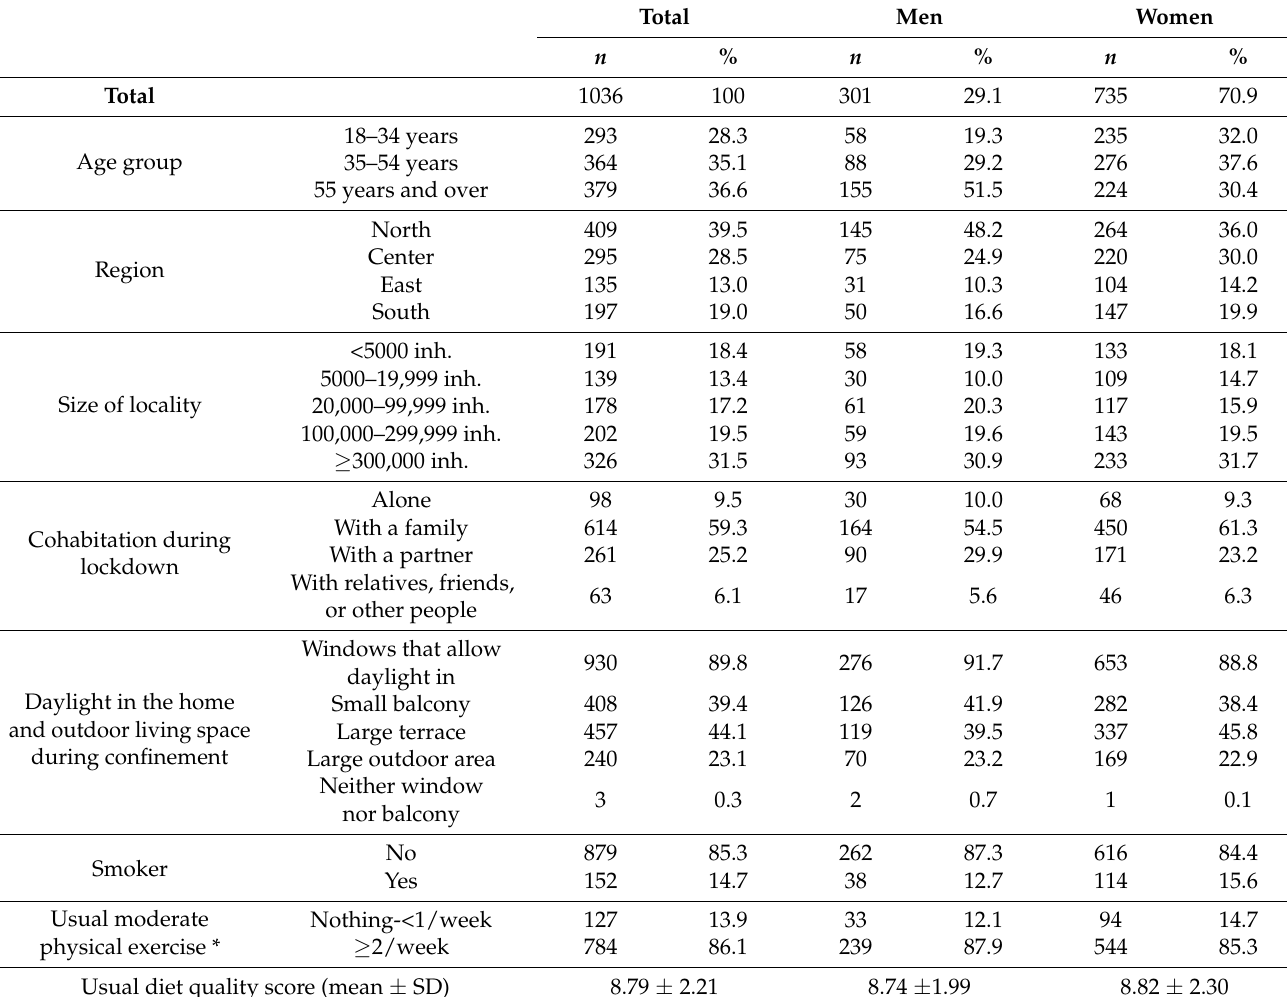
Table 1. Sociodemographic characteristics of participants, general and specific in relation to the lockdown period, by